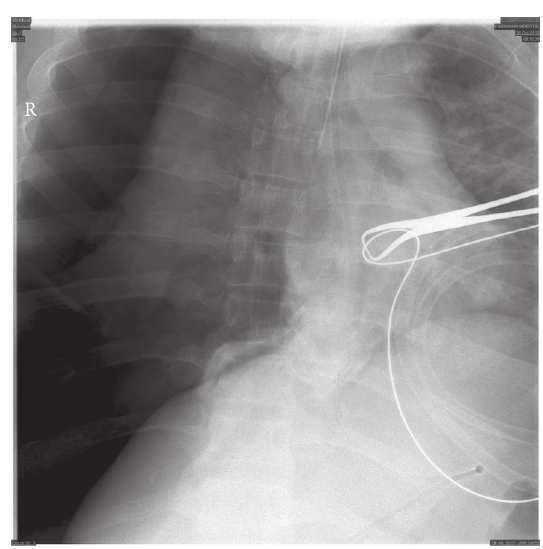
Figure 3: Intraoperative chest radiograph showing right-sided